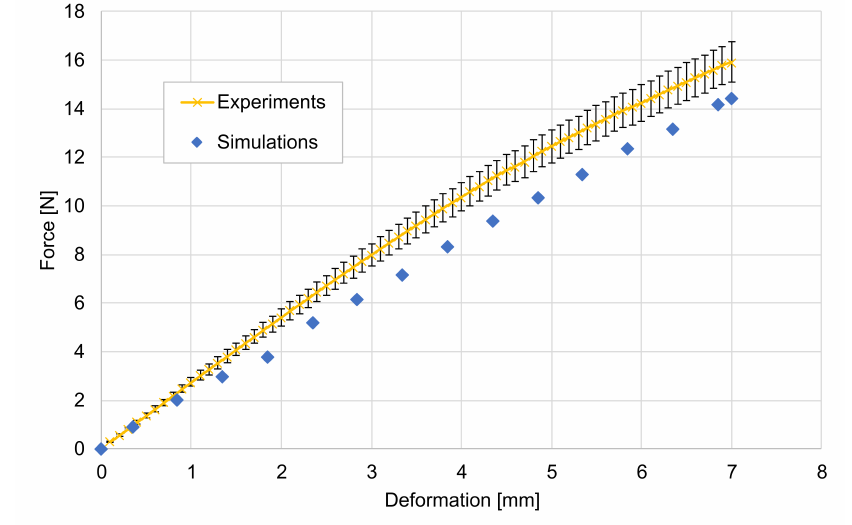
Figure 8. Force-displacement characteristics for three-point bending tests (calcium chloride concentration 5